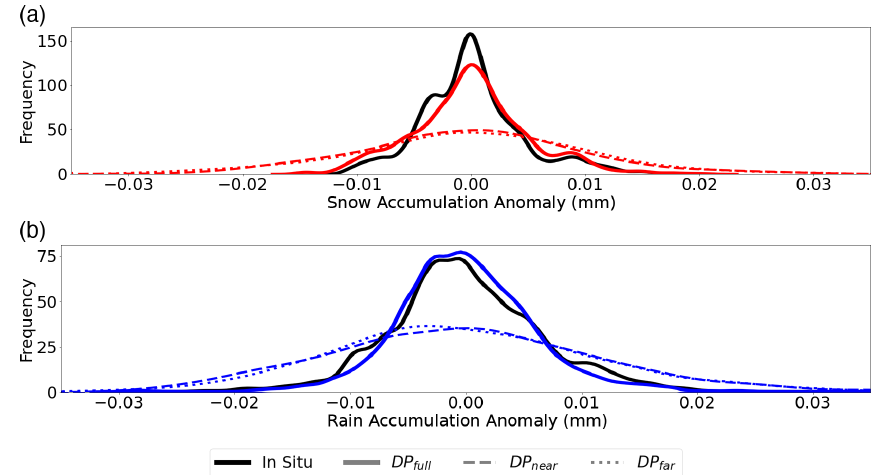
Figure 7. Phase-partitioned surface precipitation accumulation anomaly frequency distributions. DeepPrecip is trained and tested on three subsets of bins from the vertical column: DP near ( < 1km), DP far (1–3km), and DP full (the entire vertical column) for (a) solid and (b) liquid precipitation.